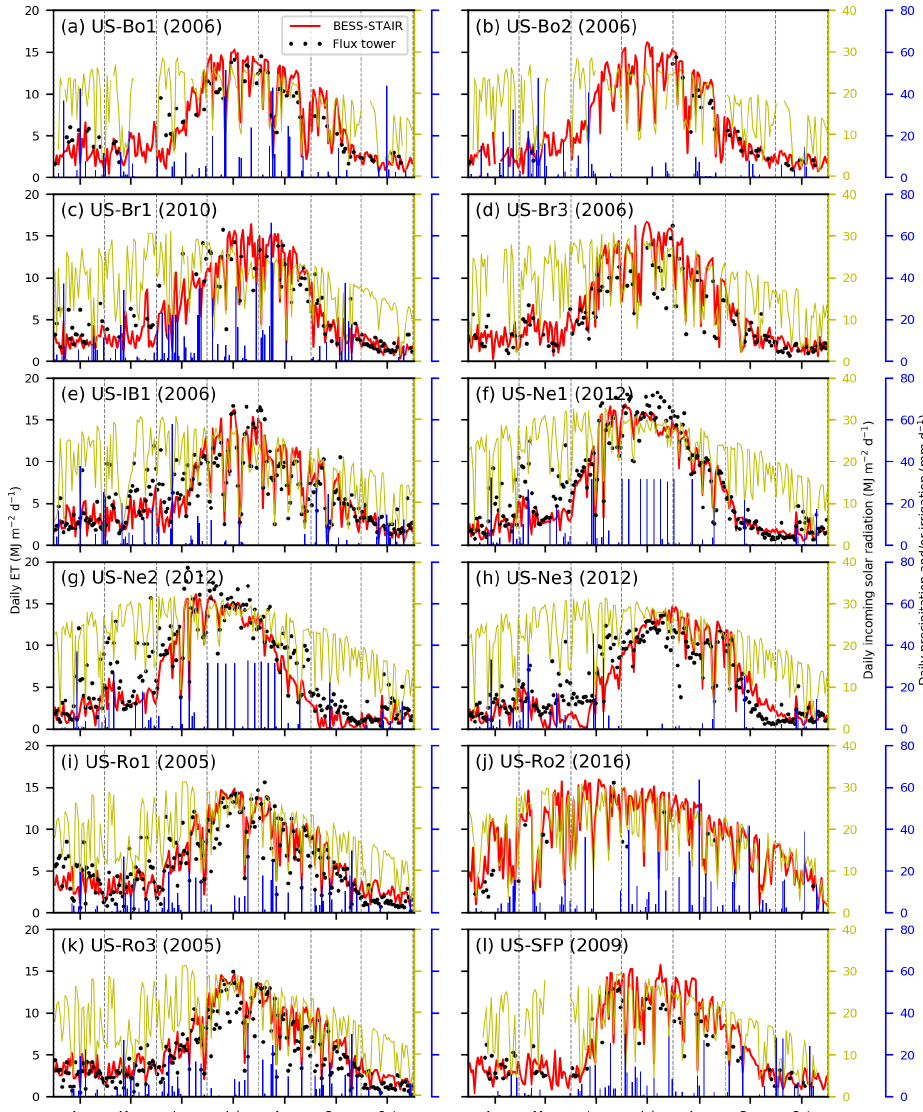
Figure 6. Seasonal time series of flux tower measured and BESS-STAIR estimated daily ET for 12 selected site years. Daily radiation and precipitation/irrigation are overlaid except for